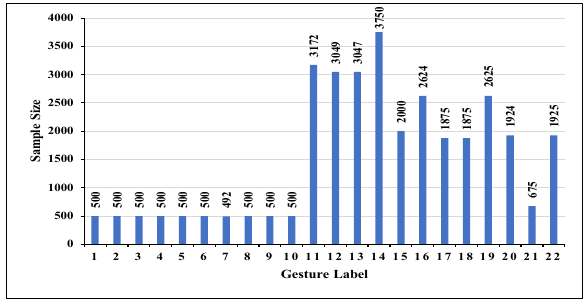
Figure 13. Data distribution of the 22